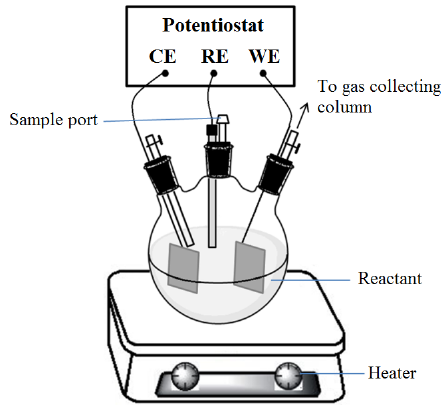
Figure 3. Schematic of the three-neck eU2A reactor. The working electrodes are Ni foil and graphene-coated Ni and the counter electrode is Pt foil, while the reference electrode is Hg/HgO. Temperature was set at 70 ◦ C. The sample port allowed collecting liquid samples and determining pH of the electrolyte in the reactor.